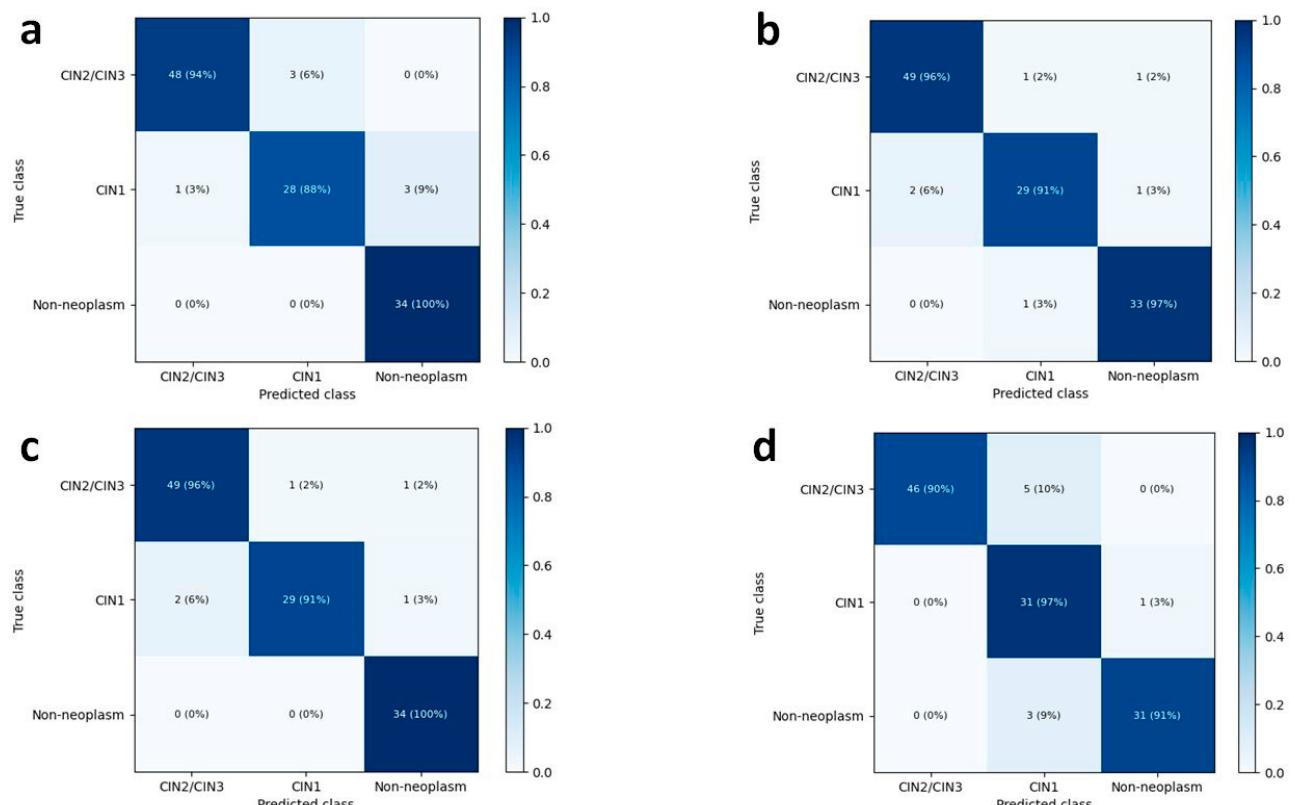
Figure 4. Heatmaps for confusion matrix of the best-performing CNN models and human pathologists in the three-class classification. The overall accuracies increased up to 94.0% by DenseNet-161 ( a ) and 94.9% by EfficientNet-B7 ( b ), similar to those of human pathologists 1 and 2, 95.7% ( c ) and 92.3% ( d ), respectively. Table 3. Per-class performances of the deep learning models in the three-class